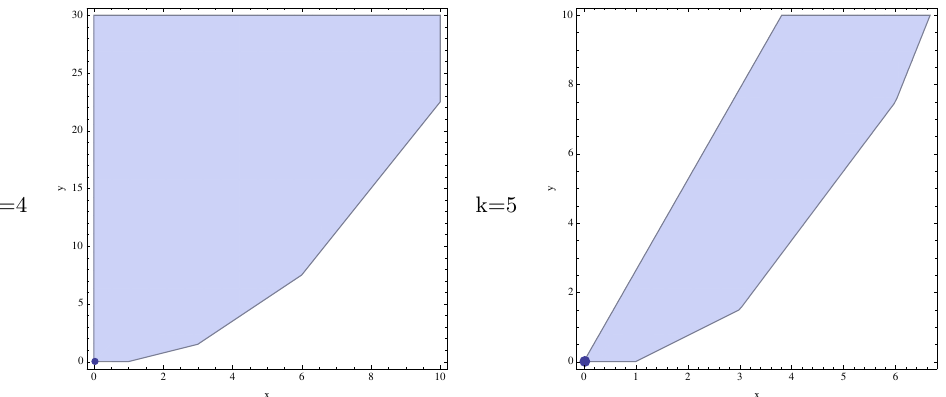
Figure 9 . The position of the string theory coefficients given in eq. (7.16) inside the region U k ∩ Y , for k = 4 , 5